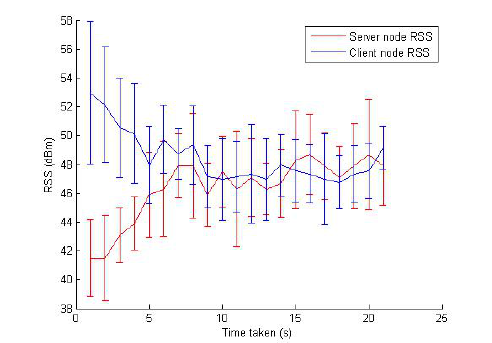
Figure 17. Change in the RSS values of server and client nodes at the relay node during the execution of the